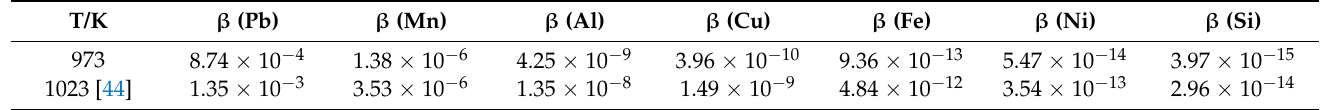
Table 2. Separation coefficients of Mg and the various impurities at different temperatures.